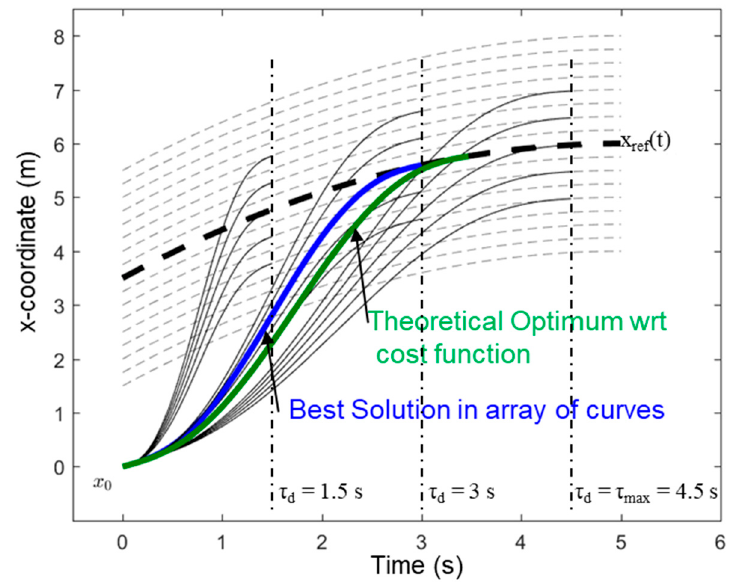
Figure 3. Example of a manifold of lateral trajectories created by the trajectory-planning algorithm [9].